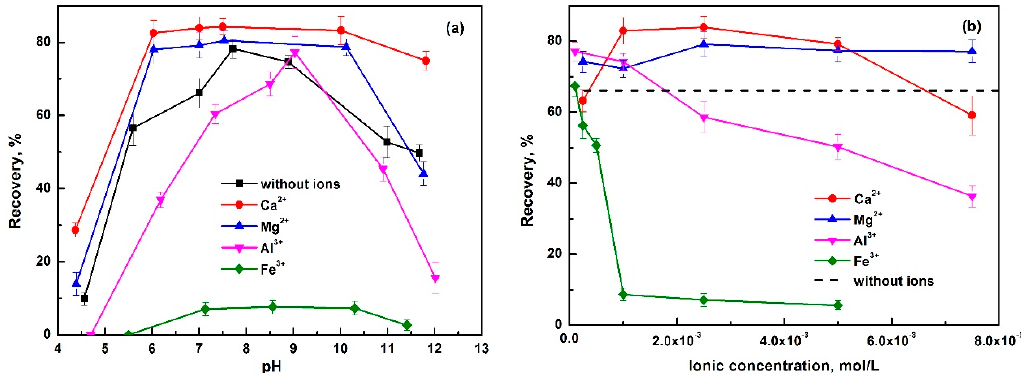
Figure 6. ( a ) Effect of pH on the floatability of apatite in the presence of metal ions at a concentration of 2.5 × 10 − 3 M; ( b ) Effect of ionic concentration on the floatability of apatite at neutral pH [5]. 2.5 × 10 − 3 M; ( b ) E ff ect of ionic concentration on the floatability of apatite at neutral pH